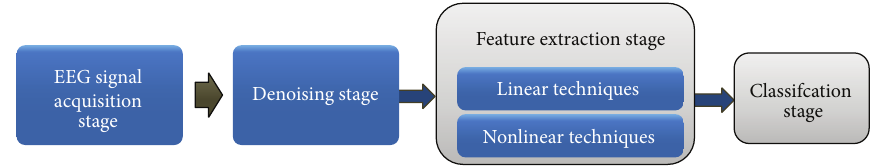
Figure 3: EEG signal processing main